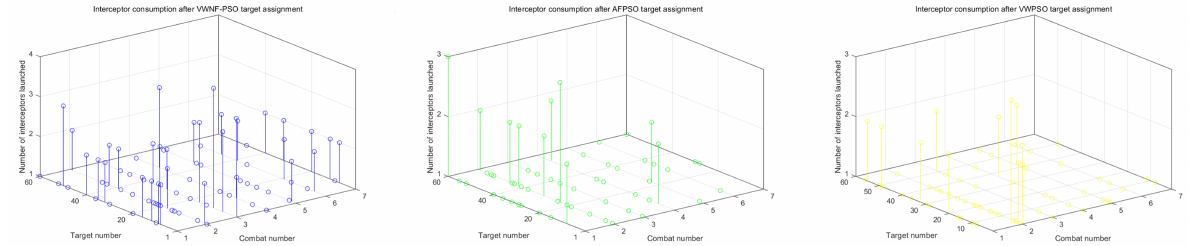
Figure 11. Number of interceptors consumed.